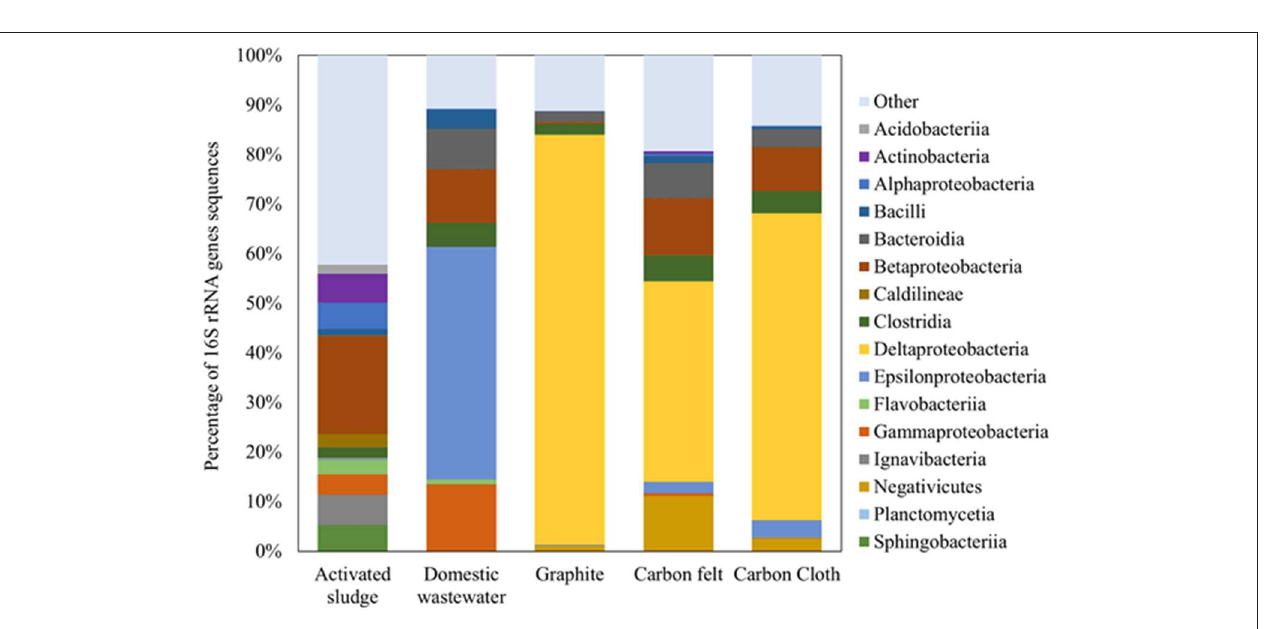
Frontiers in Energy Research |